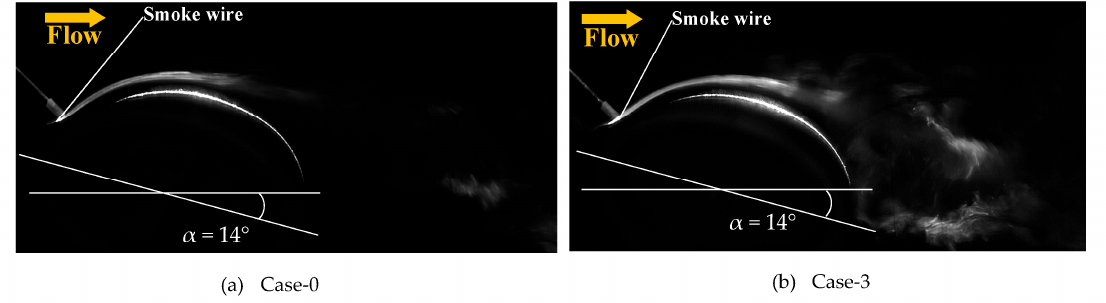
Figure 10. Smoke-wire flow visualization around upper surface of test model ( α = 14°, Re = 1.0 × 10 5 ).